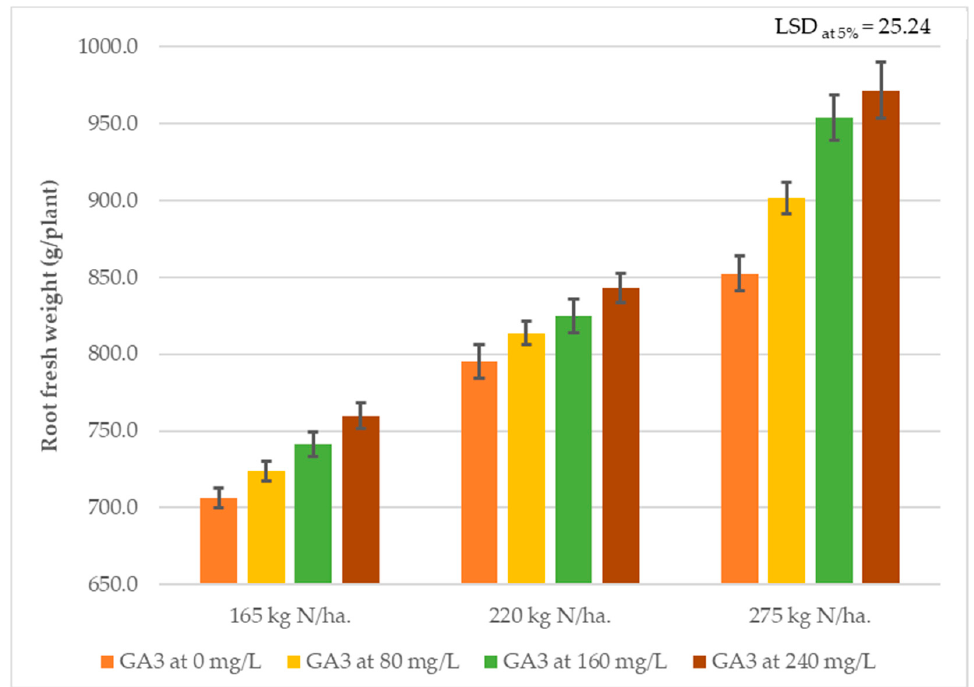
Figure 1. Root fresh weight (g/plant) as affected by the interaction between nitrogen fertilizer levels and GA 3 spraying concentrations in the first season (2014/2015).